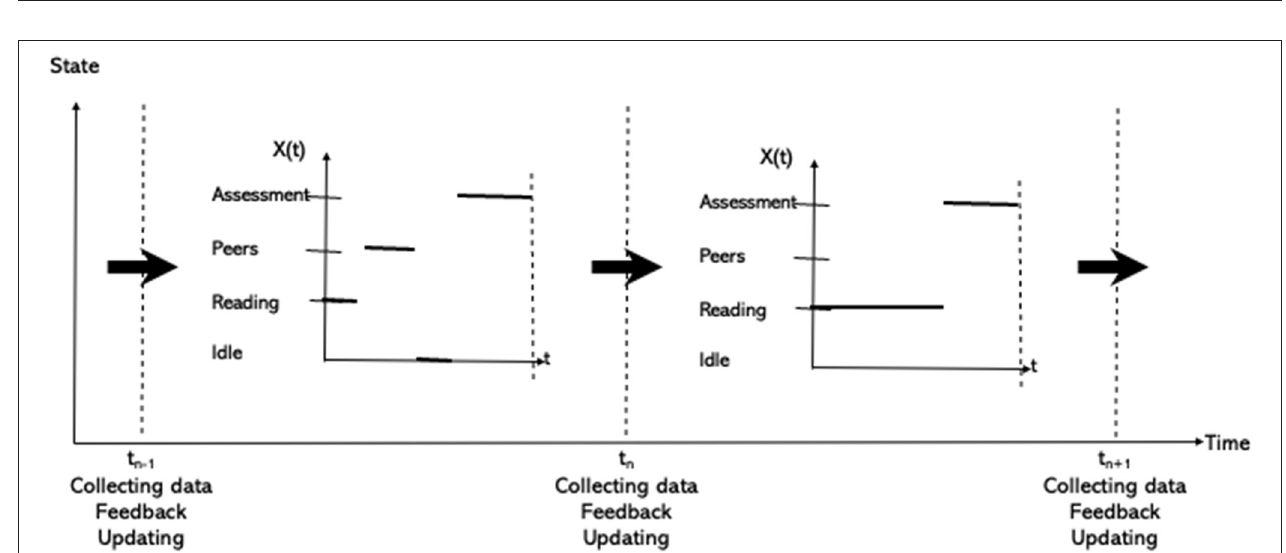
FIGURE 10 | An illustration of some of the activities of a learner during two learning sessions.